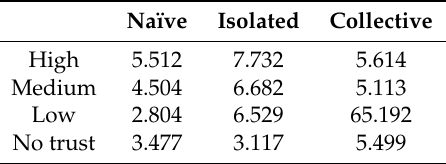
Table 5. Service time with 50% malicious.